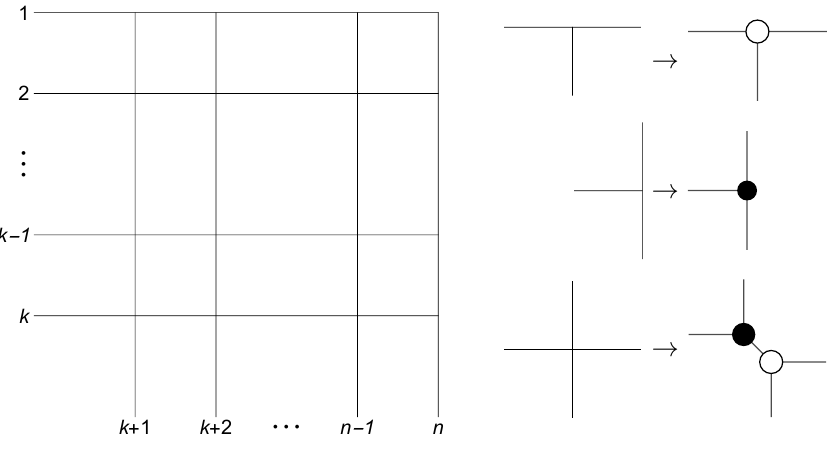
Figure 14 . Postnikov diagram for n -point N k (cid:0) 2 MHV amplitude in N = 4